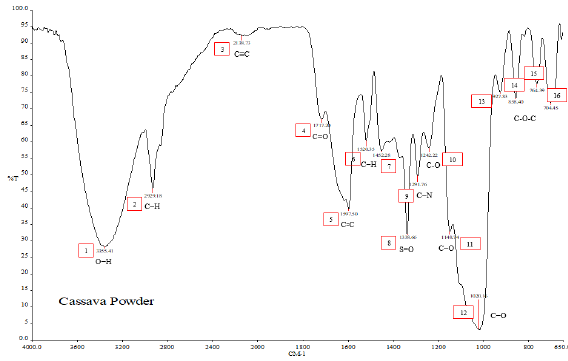
Fig. 1. FTIR spectra of CPP